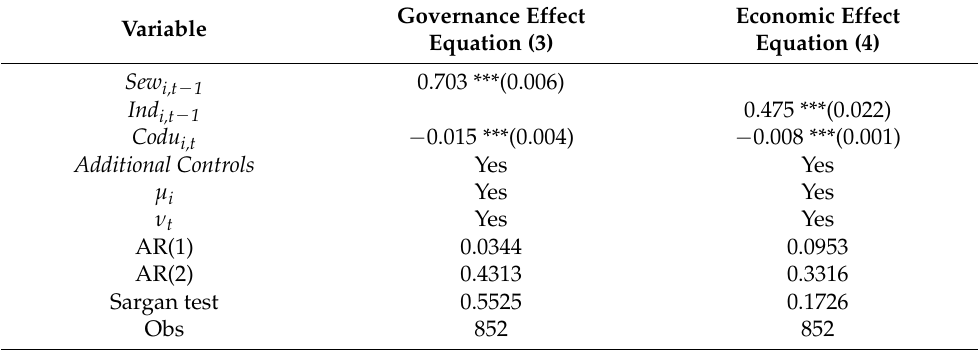
Table 3. Estimation results using upstream water quality as an instrumental